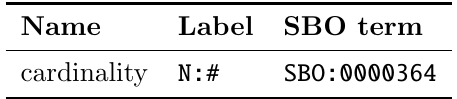
Table 2.6: The format of the possible values for the cardinality unit of information (Sec- tion 2.2.5). Here, # stands for the number; for example, “ N:5